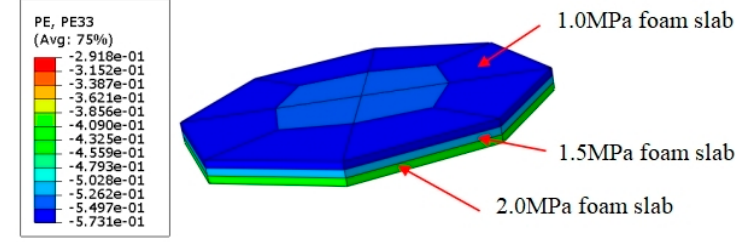
Figure 20. Plastic strain contour of foam concrete slab.